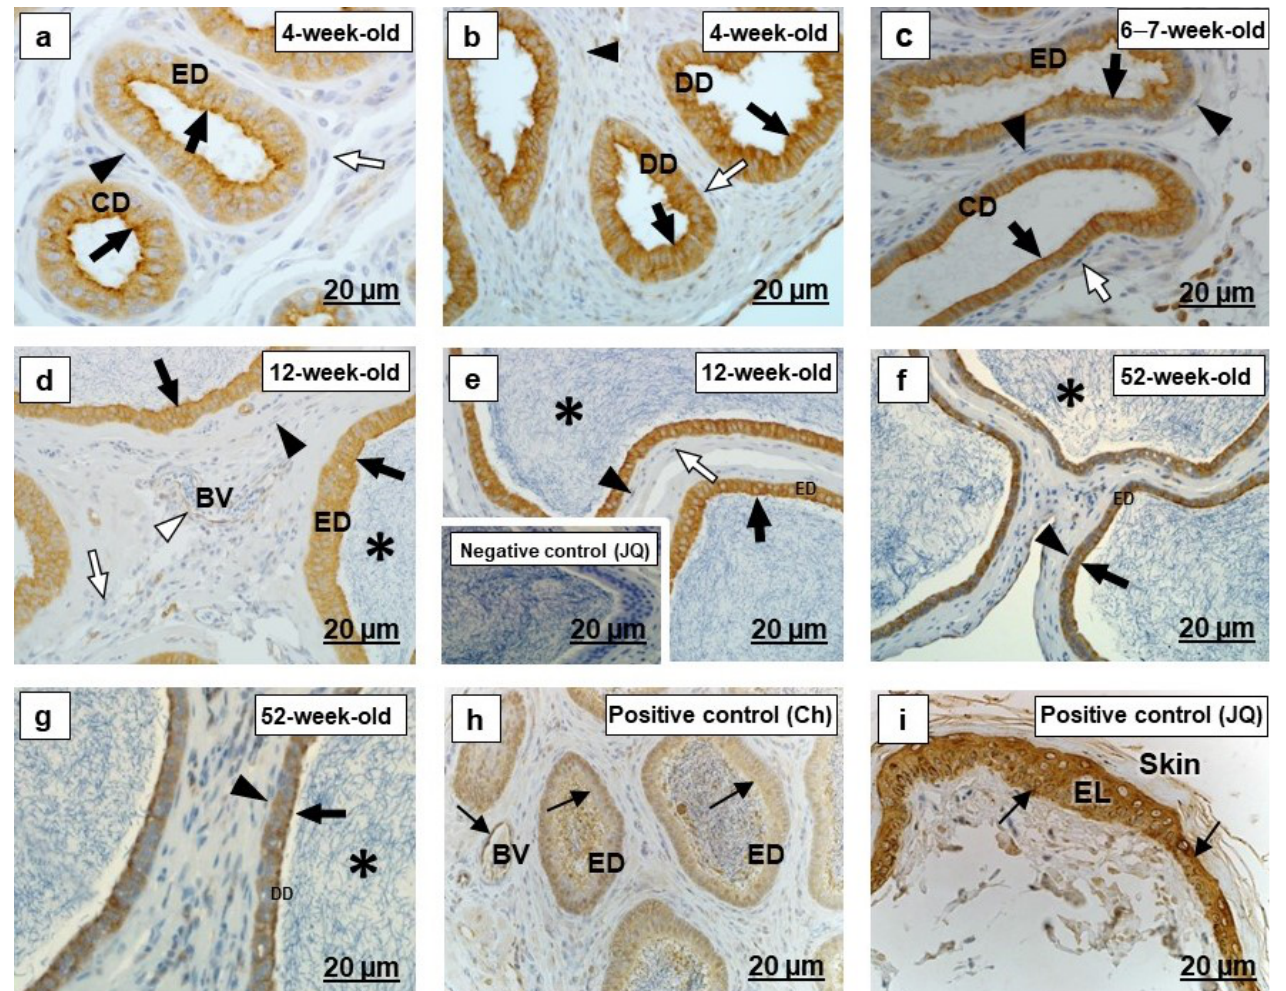
Figure 2. Immunolocalization of cytokeratin 5 in the epididymal duct unit- (CD) connecting duct, (ED) epididymal duct and (DD) ductus deferens of the testicular excurrent duct system of Japanese quails ( n = 7 per age group). ( a – e ) Strong immunostaining in the epithelia (black arrows) of the CD, ED and DD. Immunonegative fibroblasts (white arrows). ( a , b ) Black arrowheads indicate weak immunostaining in the smooth muscle cells. ( f , g ) Moderate immunostaining in the epithelia (black arrows) of the ED and DD. ( c – g ) Negative to weak immunostaining in the smooth muscle cells (black arrowheads). ( d ) Moderate immunostaining in the vascular endothelial cell (white arrowhead). ( d – g ) Immunonegative luminal spermatozoa (asterisks). Inset ( e ) Negative control: Epididymal duct of an adult Japanese quail. ( h , i ) Positive controls: Thin black arrows indicate immunopositive labeling in the epididymal duct epithelium and vascular endothelial cells of the adult chicken ( h ) and epidermal layer (EL) of an adult Japanese quail skin tissue ( i ). BV, Blood vessel. Ch, Chicken. JQ, Japanese